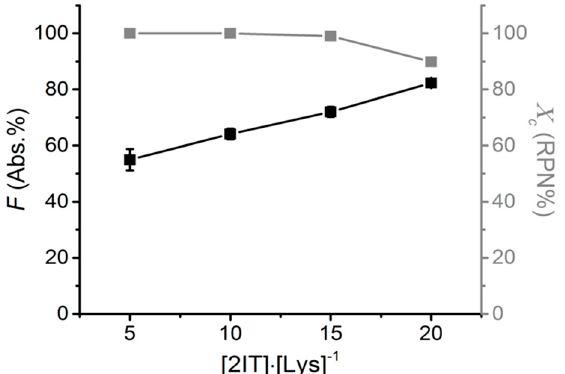
Figure 1. Degree of functionalisation ( F ) and triple helix preservation ( X c ) in collagen products reacted with 2IT at varied [2IT]:[Lys] − 1 molar ratios. Data presented as mean ± SEM.